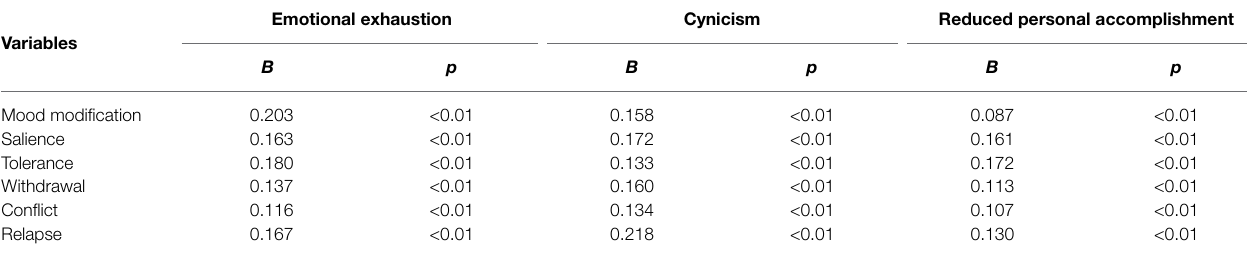
TABLE 8 | Linear regression results between SMA and burnout dimensions. Emotional Variables